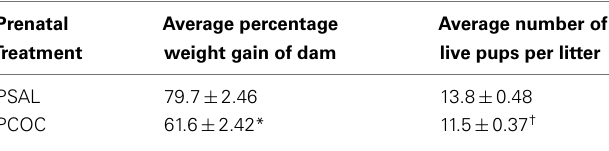
Table 1 | Effect of prenatal cocaine treatment on dam weight gain and offspring